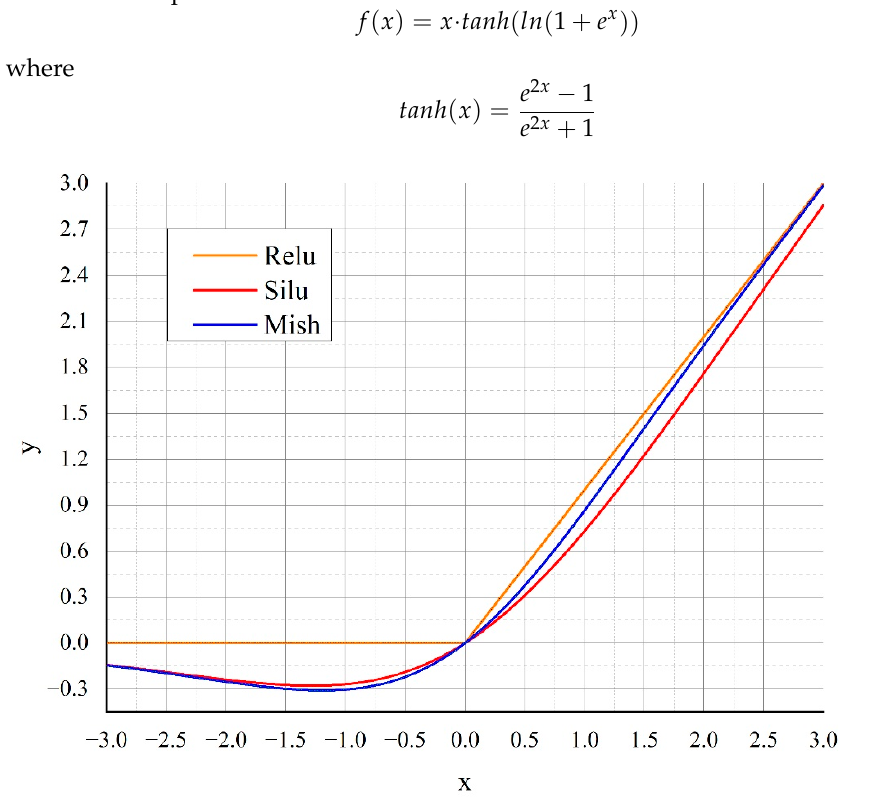
Figure 7. Comparison of activation functions.